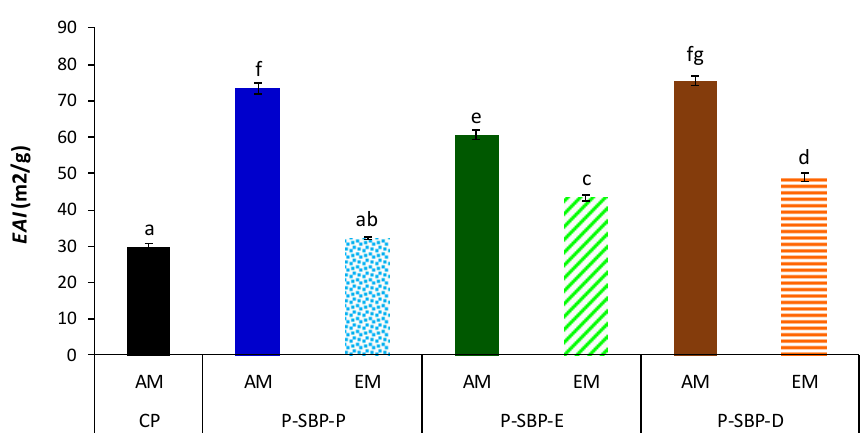
Figure 3. Emulsifying activity index (EAI) of pectin obtained from sugar beet by-products by acid or enzymatic methods. CP: citrus pectin. P-SBP-P: pectin of sugar beet pulp pressed, P-SBP-E: pectin of sugar beet pulp ensiled, P-SBP-D: pectin of sugar beet pulp dried. AM: Acid method. EM: Enzymatic method. Different letters (a–d) in the columns denote significant difference ( p < 0.05).